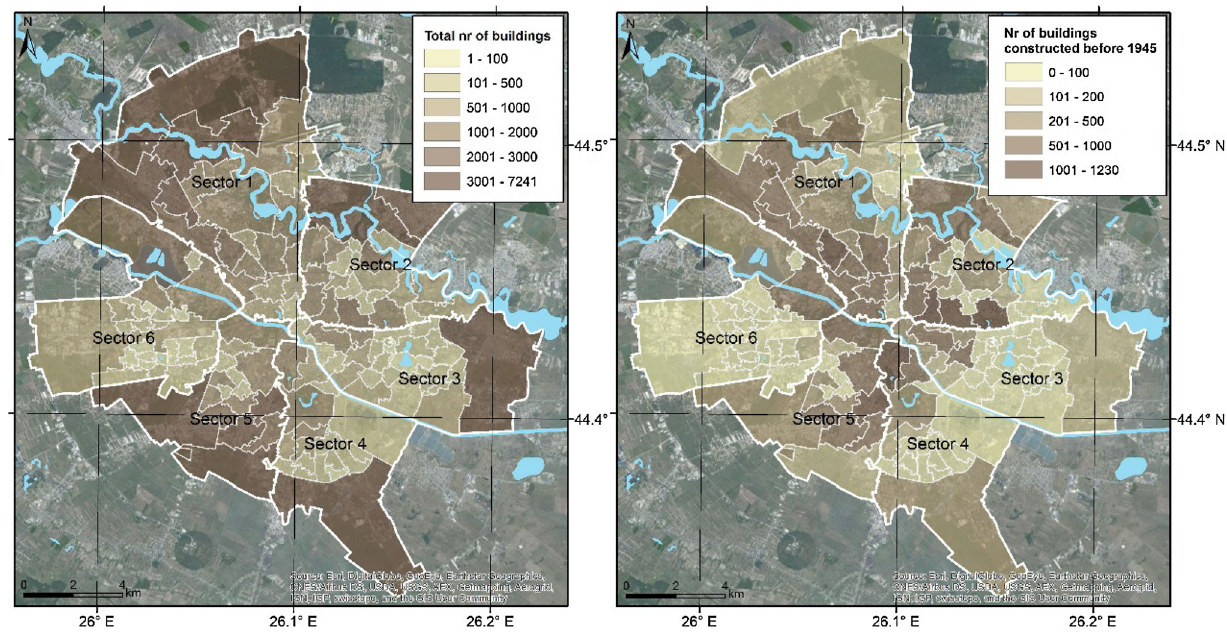
Fig. 4 Distribution of the total number of buildings in Bucharest ( left ) and the number of buildings erected before 1945, therefore without seismic design code consideration ( right ). Source Romanian 2011 census (INS 2017) Table 4 Original structure of the 2011 census dataset for residential buildings 131,875 buildings in total 128 census tracts (CT) for Bucharest (variable size) For each CT, number of residential buildings according